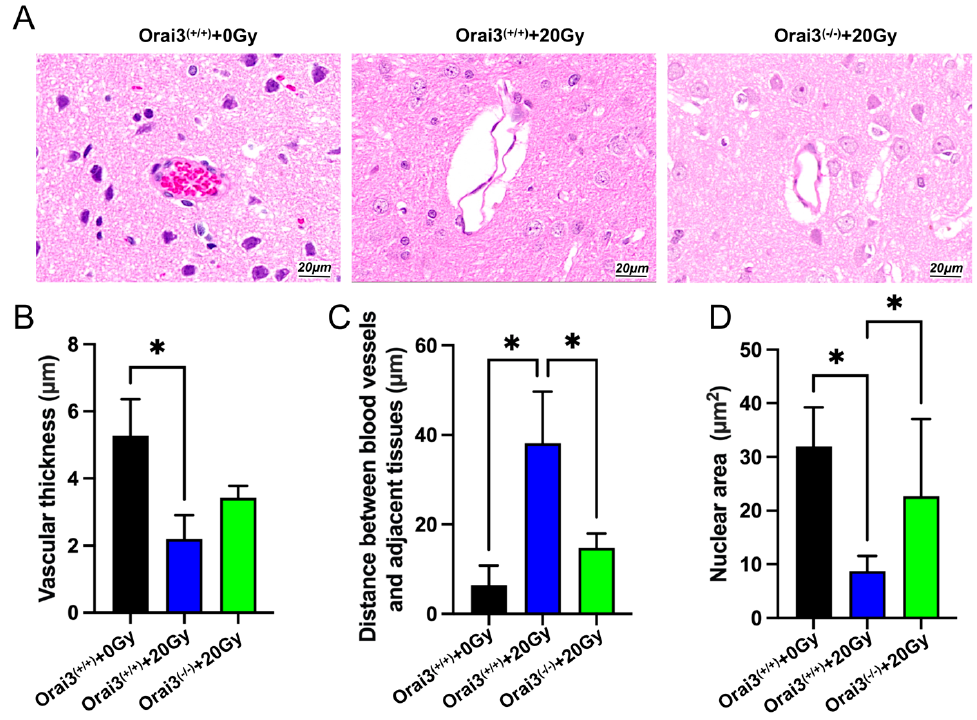
Figure 8. Role of Orai3 in X-ray irradiation-induced rat brain tissue injury. Brain tissue histopatho- logical sections showing tissue changes in wild-type rats (Orai3 (+/+) ) after whole-brain exposure to a single dose of X-ray irradiation (20 Gy), and Orai3 knockout rats (Orai3 (-/-) ) exposed to the same radiation. ( A ) Representative images showing hematoxylin and eosin (HE) staining of brain tissue slices. ( B - D ) Quantification of vascular thickness ( B , n = 3), distance between blood vessels and surrounding tissues ( C , n = 3), and nuclear area of vascular cells ( D , n = 9) in brain tissue slices. Data are shown as the mean ± SEM, * p < 0.05 analyzed by one-way analysis of variance followed by Dunnett’s multiple comparisons test.